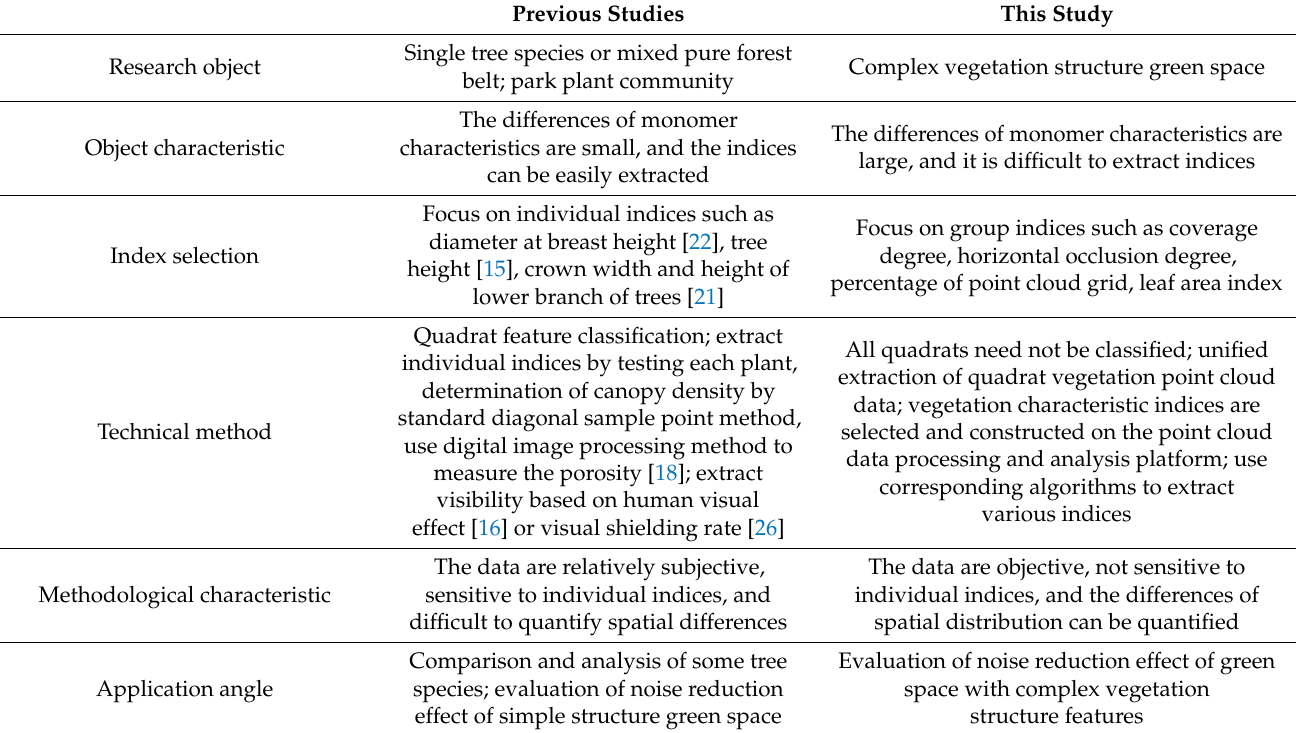
Table 1. Comparison between this study and previous